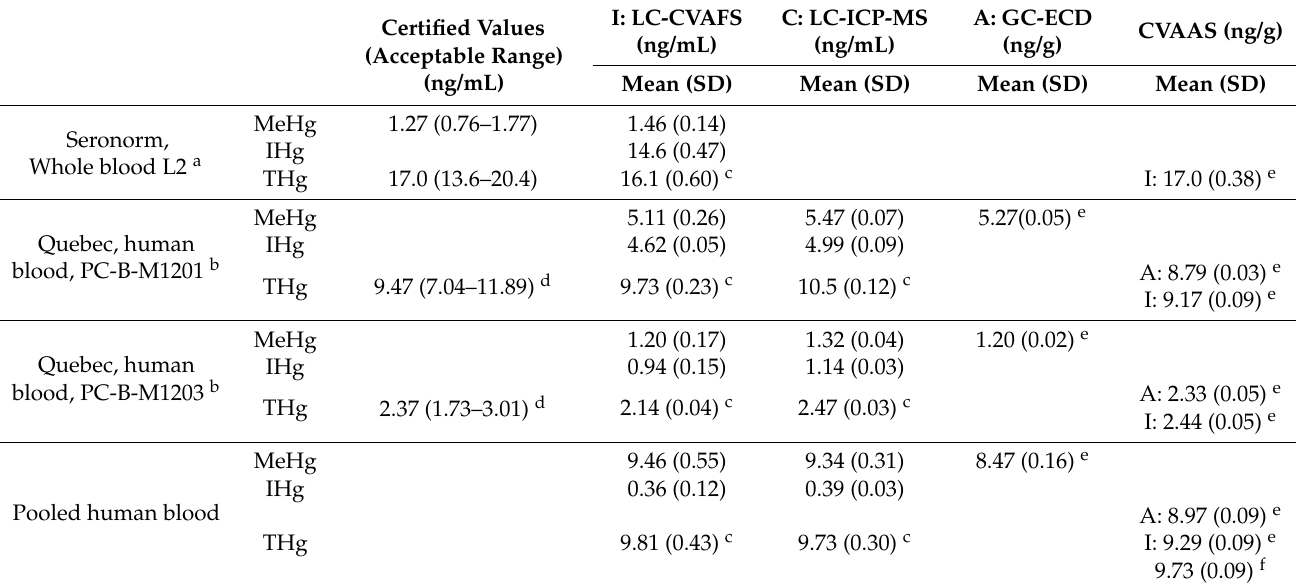
Table 5. Interlaboratory comparison of the concentrations of methylmercury, inorganic mercury, Japan Environment and Children’s Study (JECS and total mercury in blood using reference